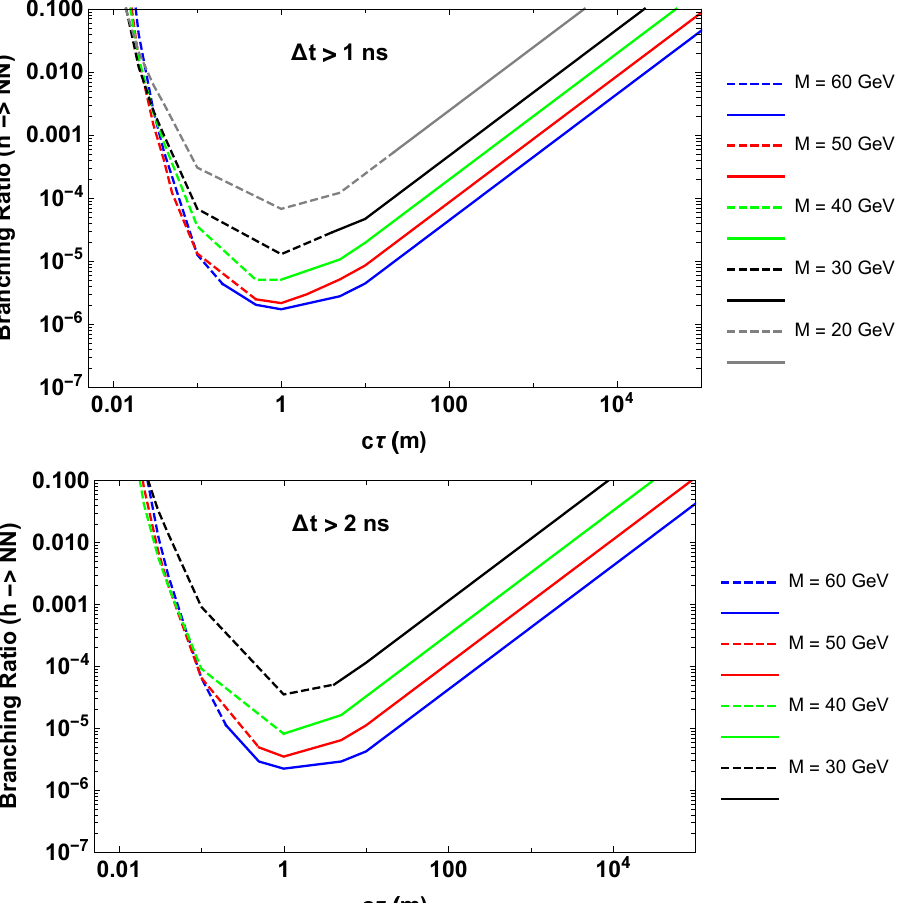
Figure 7 . 95% C.L. exclusion limits of Higgs branching ratio to two right-handed neutrinos as a function of c(cid:28) for di(cid:11)erent right-handed neutrino masses in the simpli(cid:12)ed model. The transition from Dashed to Solid lines marks the c(cid:28) values at which the physical neutrino mass arising from the see-saw mechanism is m (cid:24) 0 : 1 eV. The top plot is for (cid:1) t > 1 ns; the bottom plot is for (cid:1) t > 2 (cid:23)